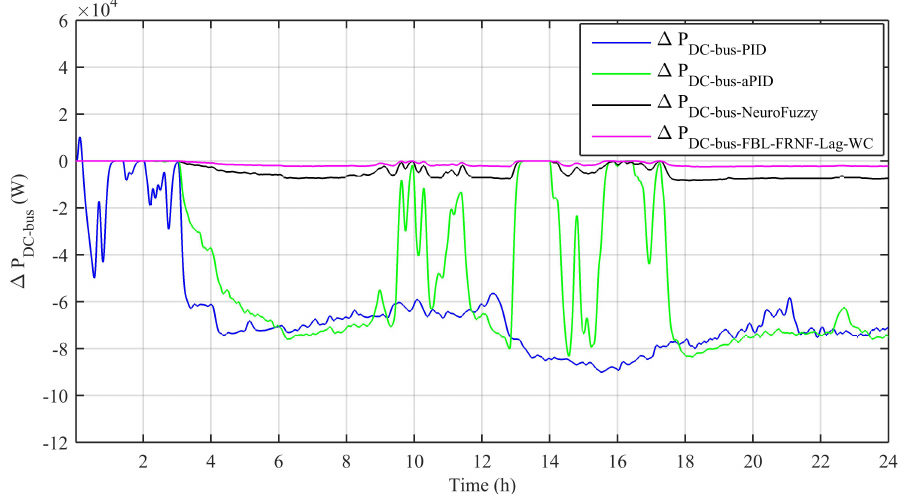
Figure 6. Net power on the DC bus, ∆ P DC